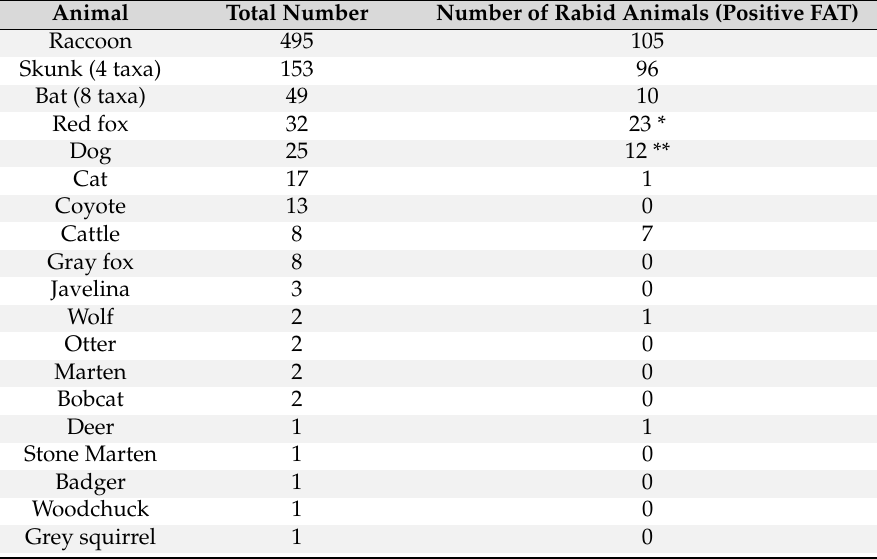
Table 1. Comparative testing of brainstem tissues of suspect rabid mammals (N =